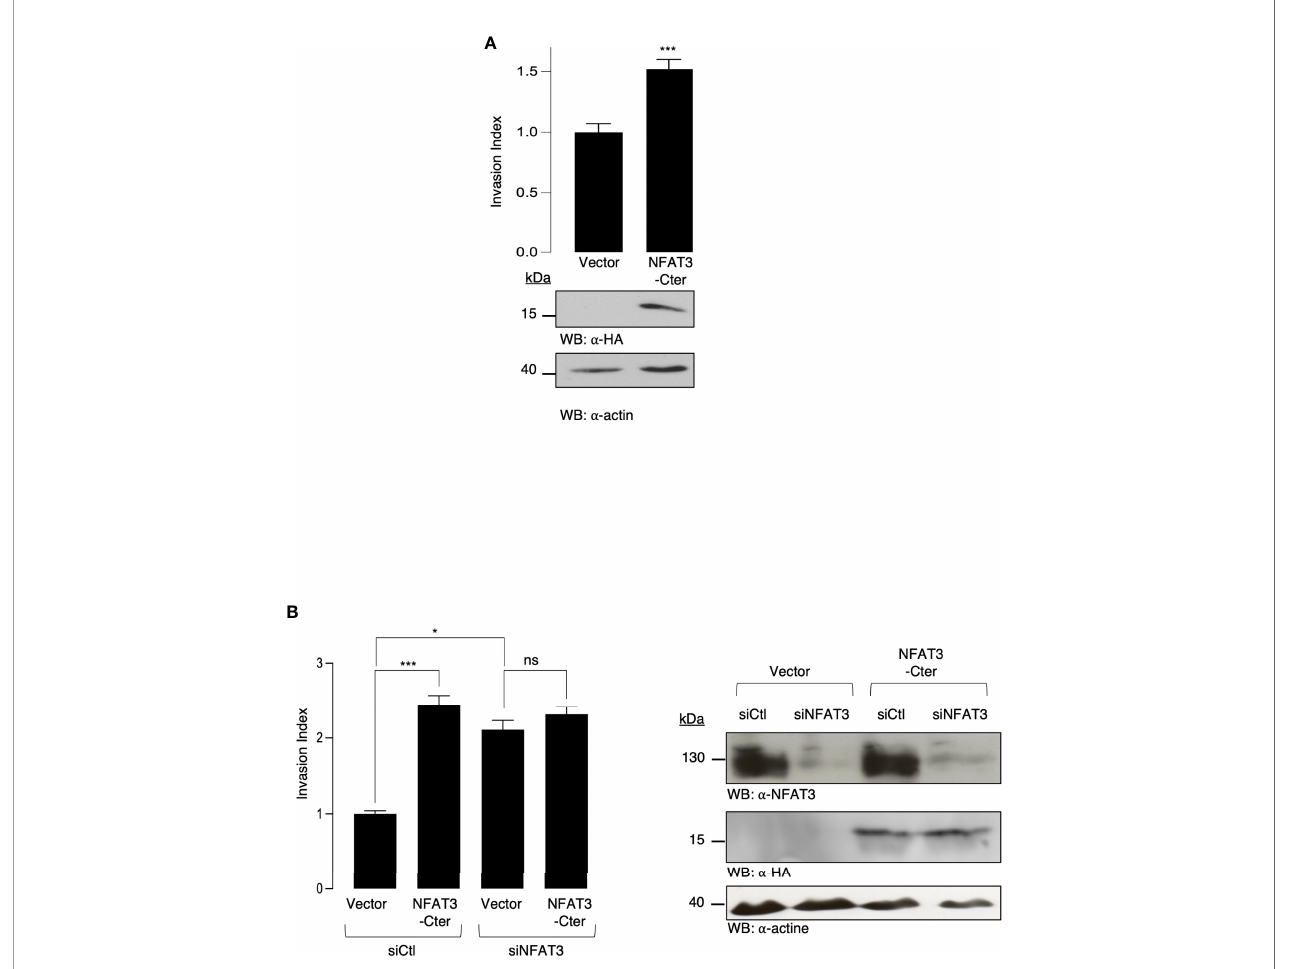
FIGURE 2 | NFAT3-Cter acts as a dominant negative form of endogenous NFAT3. (A) T-47D cells were transiently transfected with either a vector encoding the HA epitope fused to NFAT3-Cter or with the empty vector (Vector). The following day, transfected cells were subjected to an in vitro invasion assay for 24 h. All data are shown as the mean of three independent experiments ± SEM (n=3 biological replicates; 3 technical replicates for each experiment; *p<0.005). Whole cell lysates were revealed by a -HA and normalized by revelation with a -actin. (B) T-47D cells were transiently cotransfected with either an siRNA control (siCtl) or an siRNA targeting the endogenous NFAT3 (siNFAT3) in combination with either a vector encoding the HA epitope fused to NFAT3-Cter or with the empty vector (Vector). Approximately 48 h later, transfected cells were subjected to an in vitro invasion assay for 24 h. The mean of three independent experiments ± SEM is shown (n=3 biological replicates; 3 technical replicates for each experiment; *p<0,05, ***p<0,001, ns, non-speci fi c). Whole cell lysates were revealed by a -HA and a -NFAT3 and normalized by revelation with a